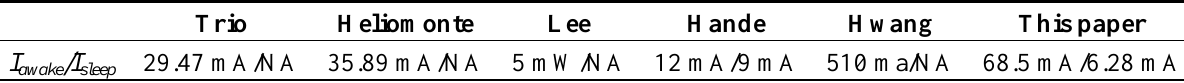
Table 4. Energy consumed by WSN modules in wake-up and sleep